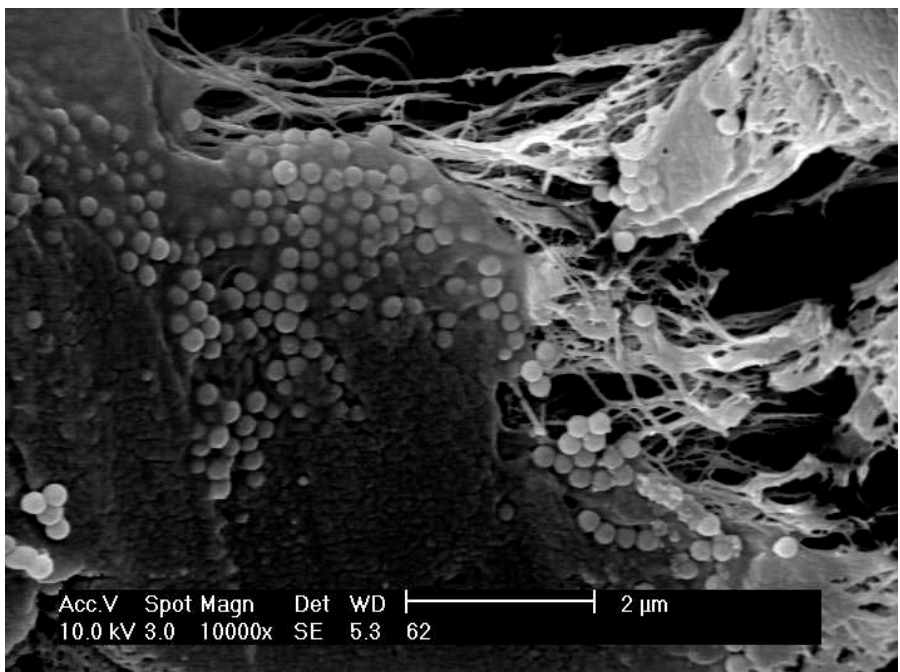
Figure 4. SEM micrograph of sPP/M200 nanocomposite (magnification 10,000×), prepared by 60 °C (see Table